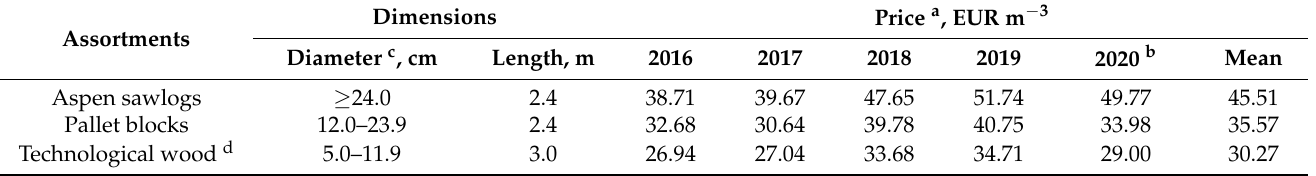
Table 2. Description and price of aspen timber assortments, applied from Joint Stock Company ‘Latvia’s State Forests’. Assortments